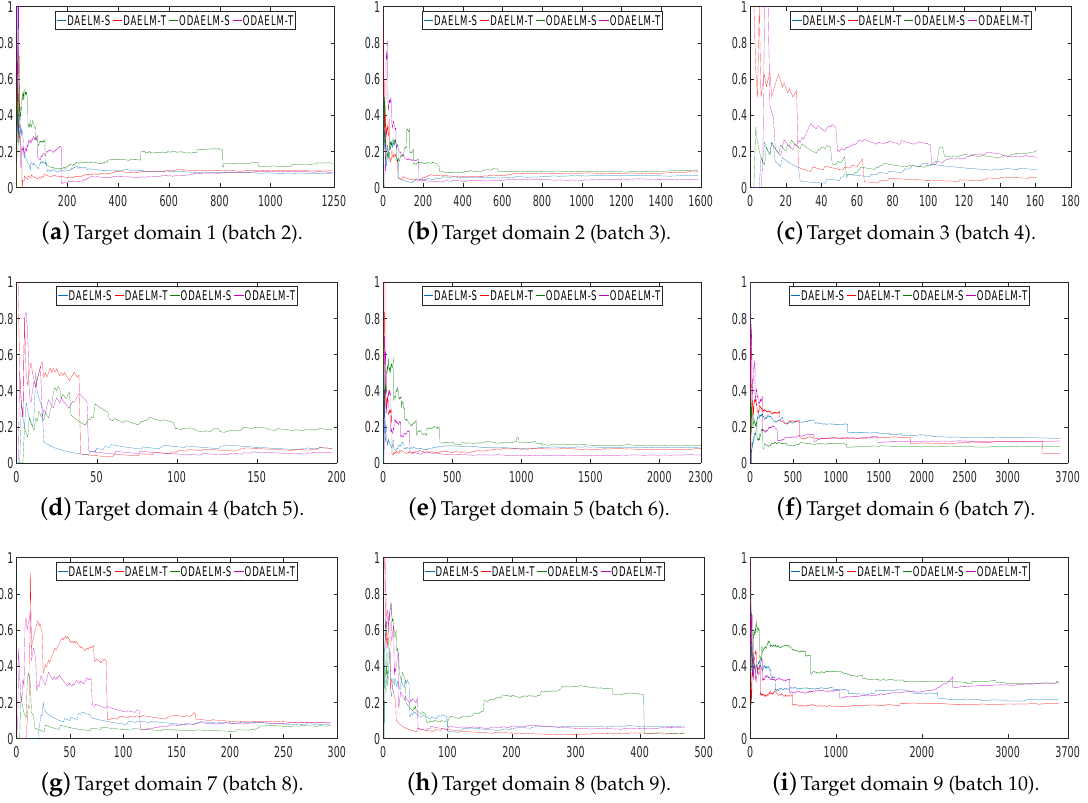
Figure 11. Classification errors on nine target domains using setting 3. The x - and y -axes are the same as Figure